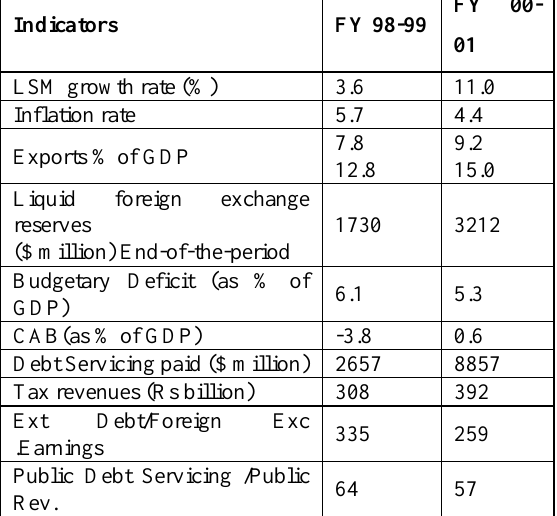
TABLE 2: Macroeconomic Indicators